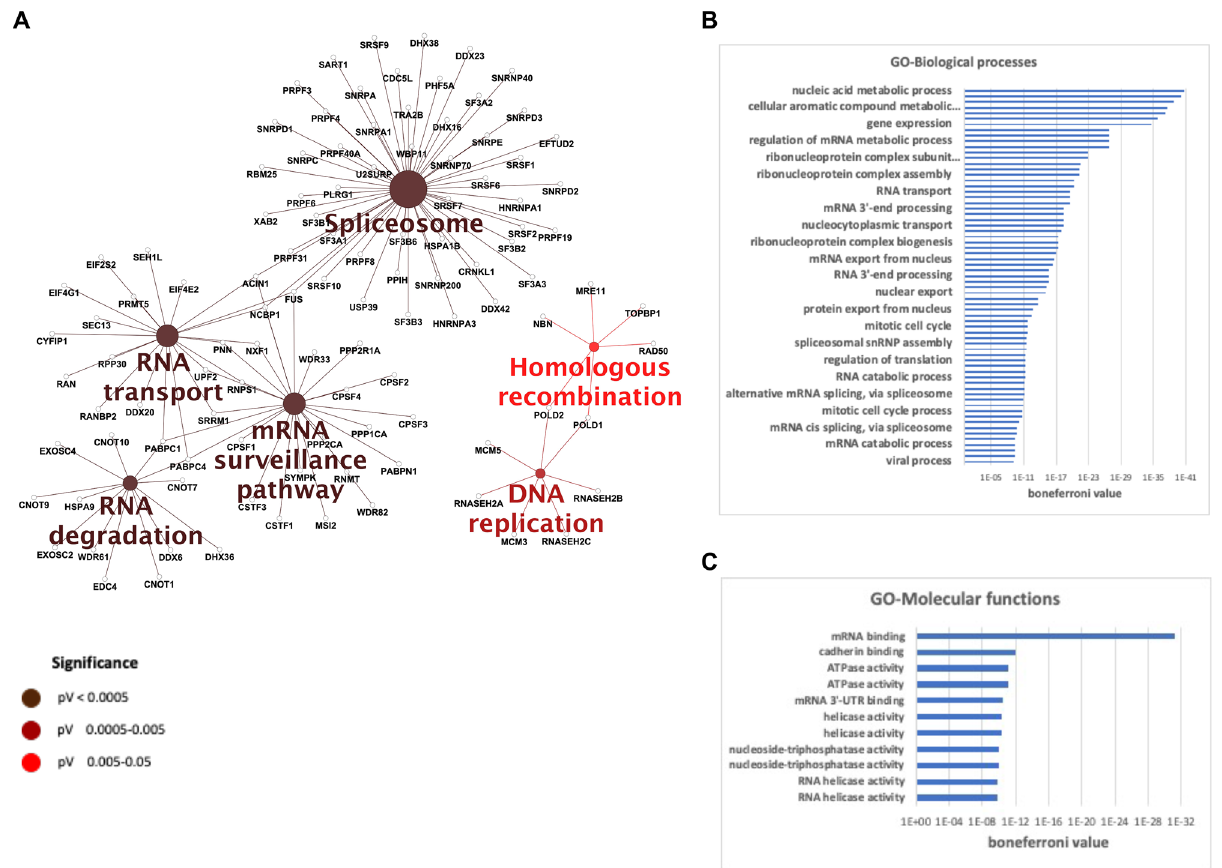
Figure 2. Most significant pathways and processes covered by constrained G4 interacting proteins. ( A ) Enriched KEGG pathways. Gene Ontology terms, ( B ) GO-Biological processes and ( C ) GO-Molecular Functions for the 425 proteins found enriched on constrained G4 structures. A right-sided (Enrichment) test based on the hyper-geometric distribution was performed on the corresponding Entrez gene IDs for each gene list and the Bonferroni adjustment ( p <